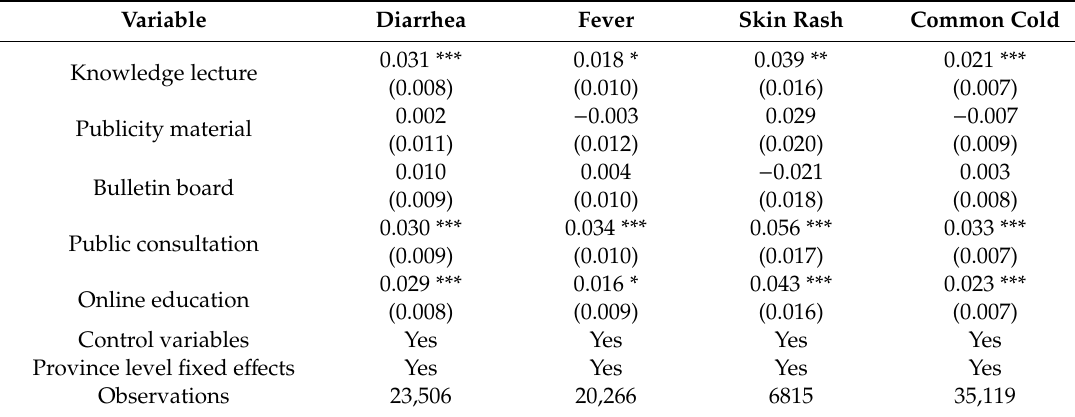
Table 5. E ff ect of di ff erent health education methods on healthcare-seeking behavior